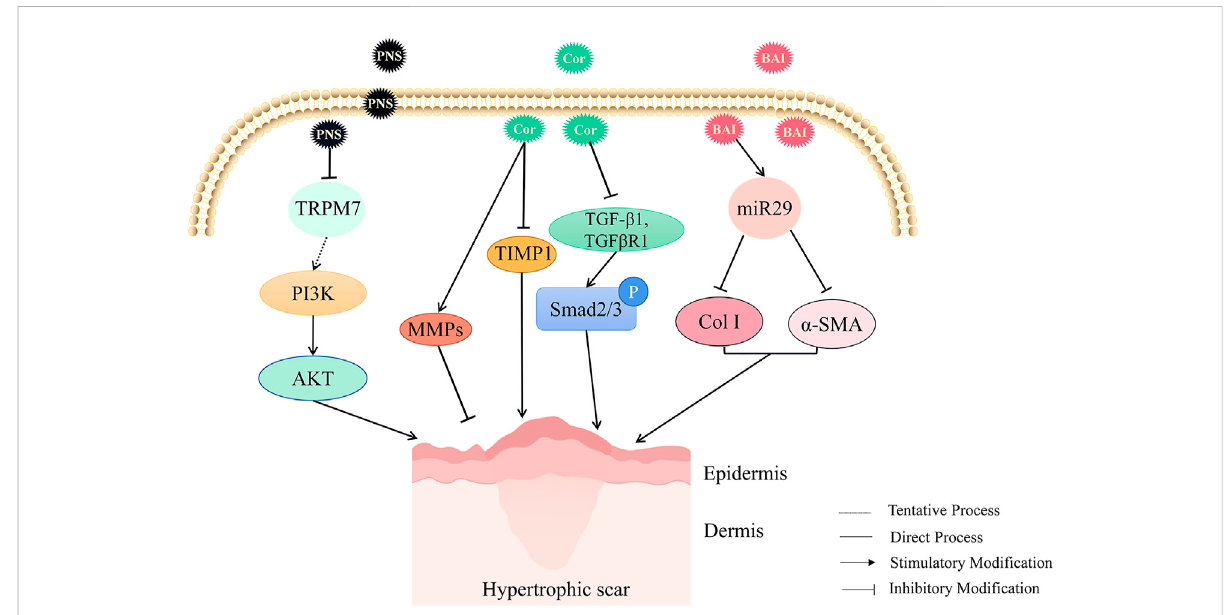
FIGURE 4 The HS inhibitory mechanism of TCM (Panax notoginseng saponins, corilagin, and baicalein) by promoting extracellular matrix degradation. Panax notoginseng saponins (PNS), corilagin (Cor), and baicalein (BAI) could promote the degradation of the extracellular matrix to reduce HS. PNS inhibited HS formation potentially by inhibiting TRPM7 and regulating PI3K/AKT signaling pathway to inhibit extracellular matrix deposition. Cor inhibited TGF- β 1, reduced the expression of p-Smad2/3, affected the levels of MMPs and TIMP1 proteins, inhibited the deposition of extracellular matrix, and thus attenuated HS. Up-regulation of miR-29 by BAI could inhibit TGF β 1-induced accumulation of total soluble collagen, collagen I, and α -SMA to alleviate